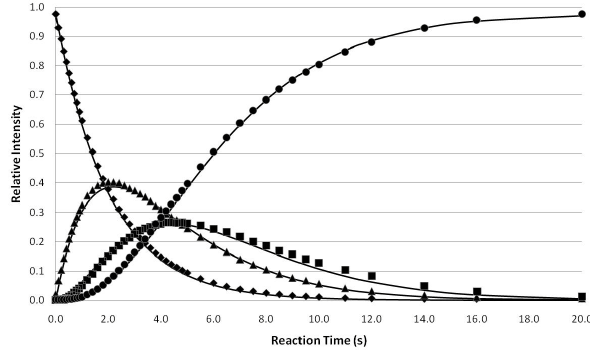
Fig. 1. Reaction profile and statistical fit for the reaction of the 3–2 ammonium bisulfate cluster with DMA. The shapes are experimen- Figure 1. Reaction profile and statistical fit for the reaction of the 3-2 ammonium bisulfate 3 tal data: diamonds represent 0DMA exchanged, triangles represent cluster with DMA. The shapes are experimental data: diamonds represent 0 DMA exchanged, 4 1DMA exchanged, squares represent 2DMA exchanged, and cir- triangles represent 1 DMA exchanged, squares represent 2 DMA exchanged, and circles 5 cles represent 3DMA exchanged. Solid lines are the statistical represent 3 DMA exchanged. Solid lines are the statistical fits. 6